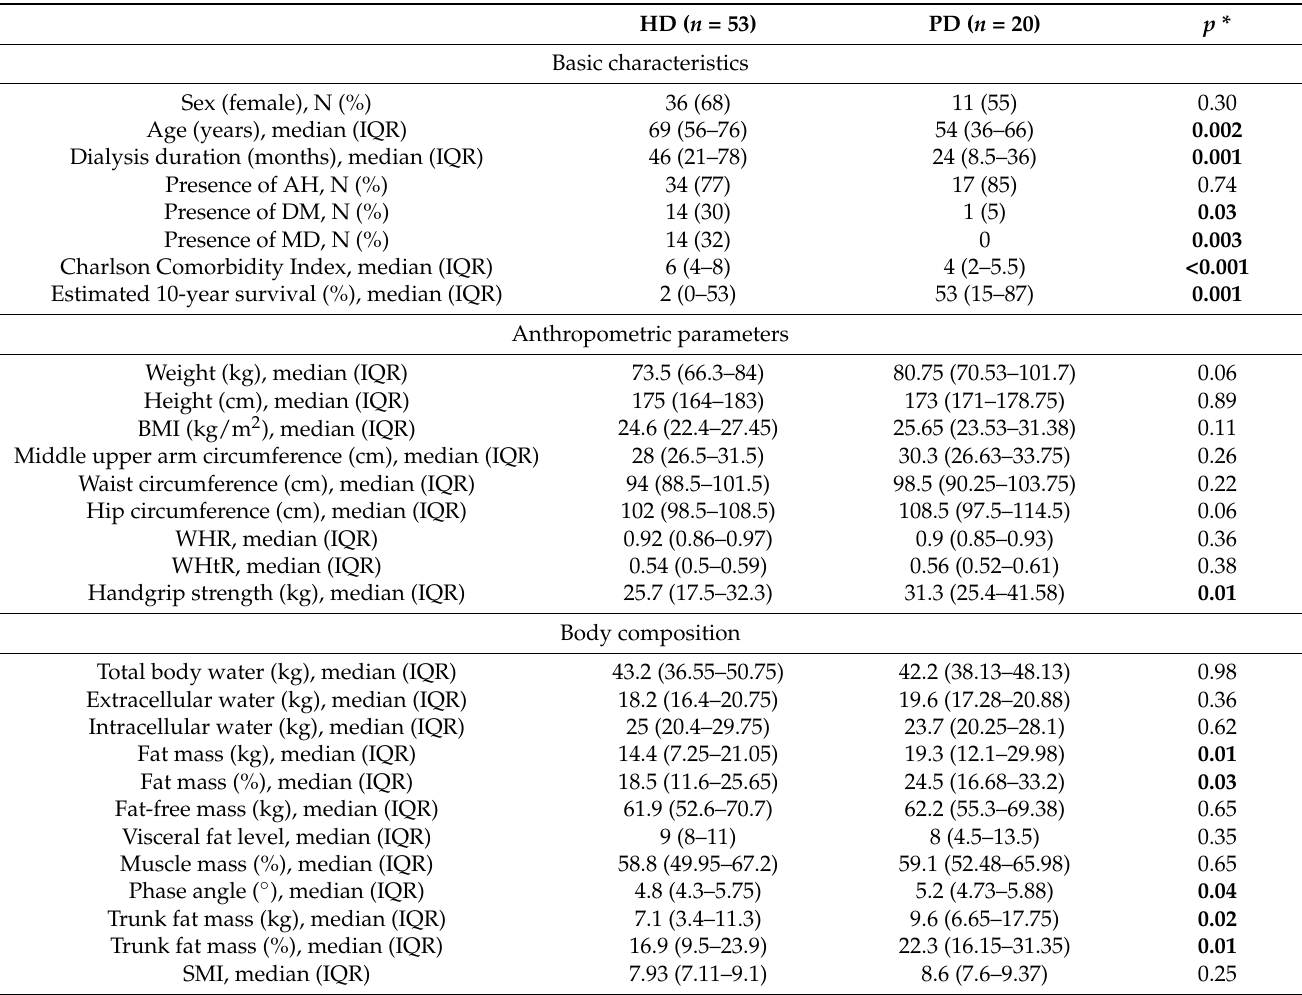
Table 1. Data about general, anthropometric, and body composition parameters of our study